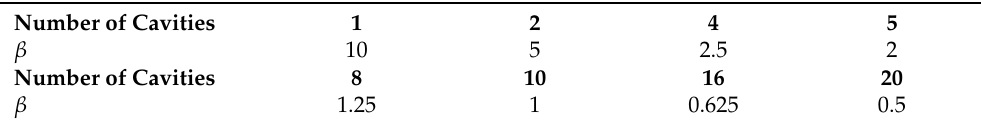
Table 1. No. of cavities and the corresponding value of β . Number of